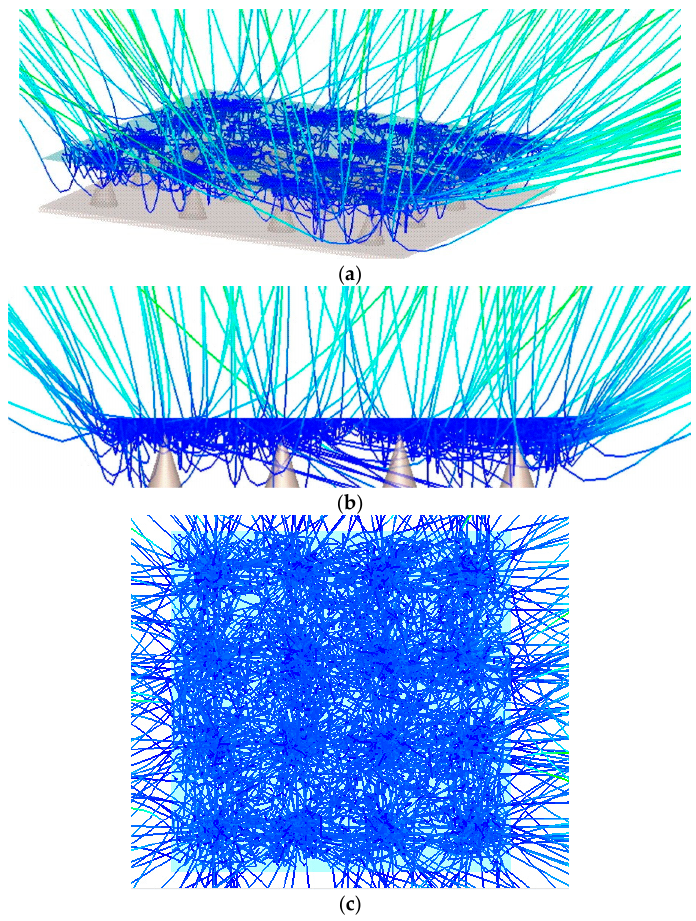
Figure 4. Simulated beam trajectories from graphene-coated Mo tip array ( a ) 3D side view; ( b ) front view; and ( c ) top view of the field emission.